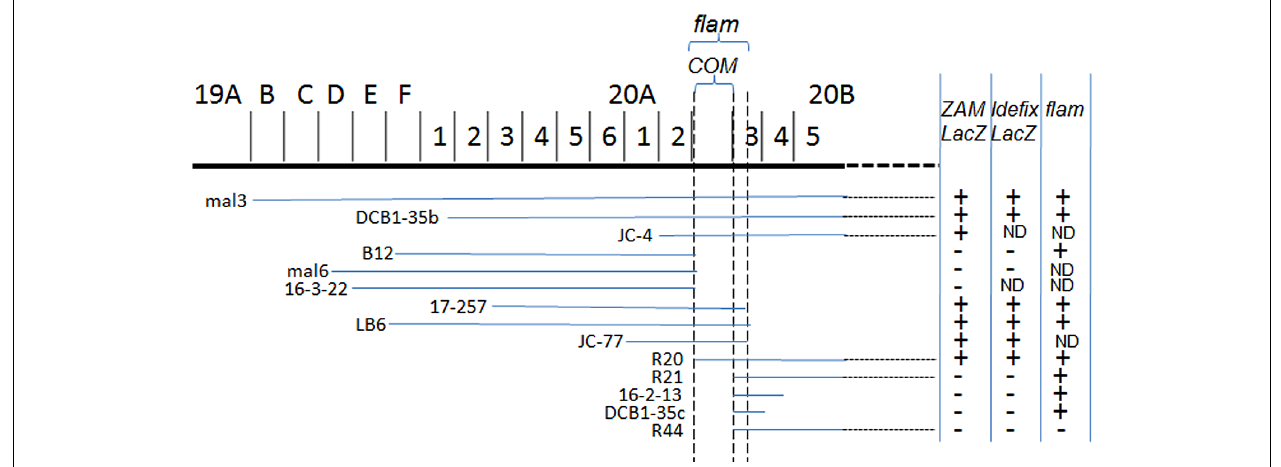
FIGURE 2 | X-chromosomal deficiencies used for cytogenetic mapping of COM . The chromosomal region is presented at the top.The lines below indicate the deficiencies tested. LacZ staining observed in these lines when